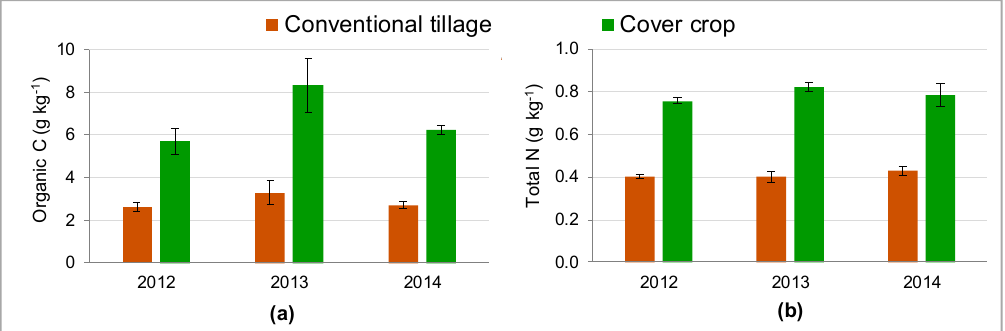
Figure 2. The trend of organic carbon ( a ) and total nitrogen ( b ) content of soil subjected to conventional tillage or cover crop during three years of experimentation. The bar on each column indicates the standard deviation (n = 3).